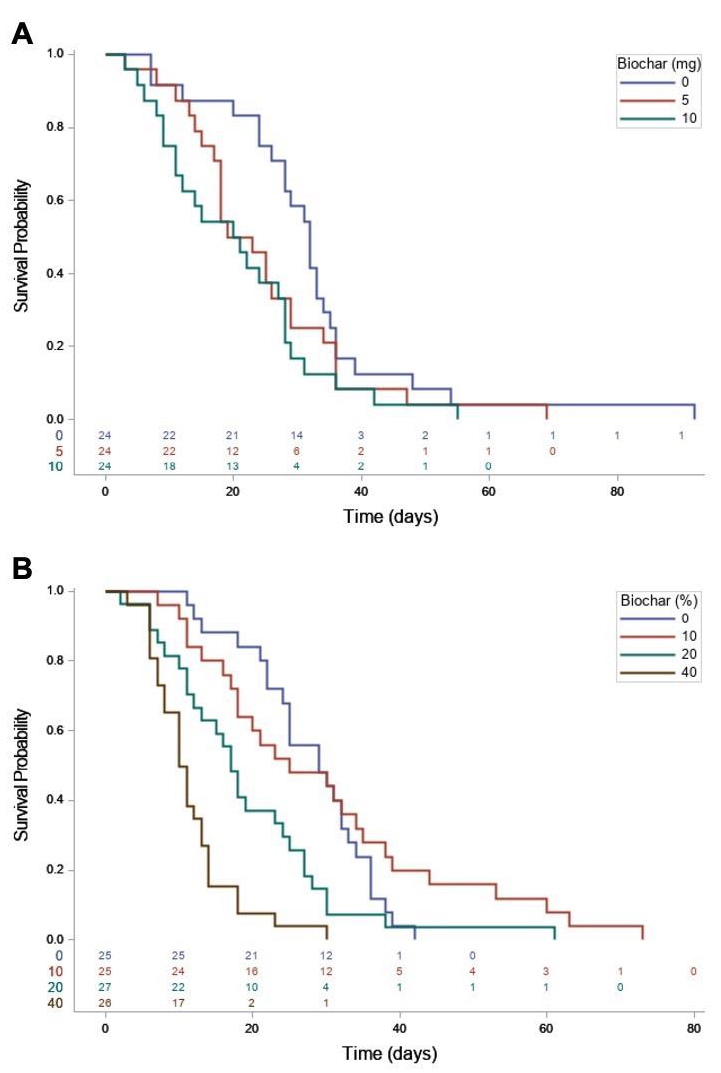
Figure 1. Kaplan–Meier survival curves for O. pseudotsugata larvae reared on ( A ) synthetic diet with dry biochar applied to the surface at three concentrations (0, 5 and 10 mg) and ( B ) biochar incorporated into synthetic diet at four rates (0, 10, 20 and 40% (by volume)) of the diet mixture. For each time interval, estimated survival percentage (survival probability), is calculated as the number of larvae surviving divided by the number of total larvae at the start of experiment for each treatment group. Counts of surviving larvae at each time point for each treatment are included beneath survival